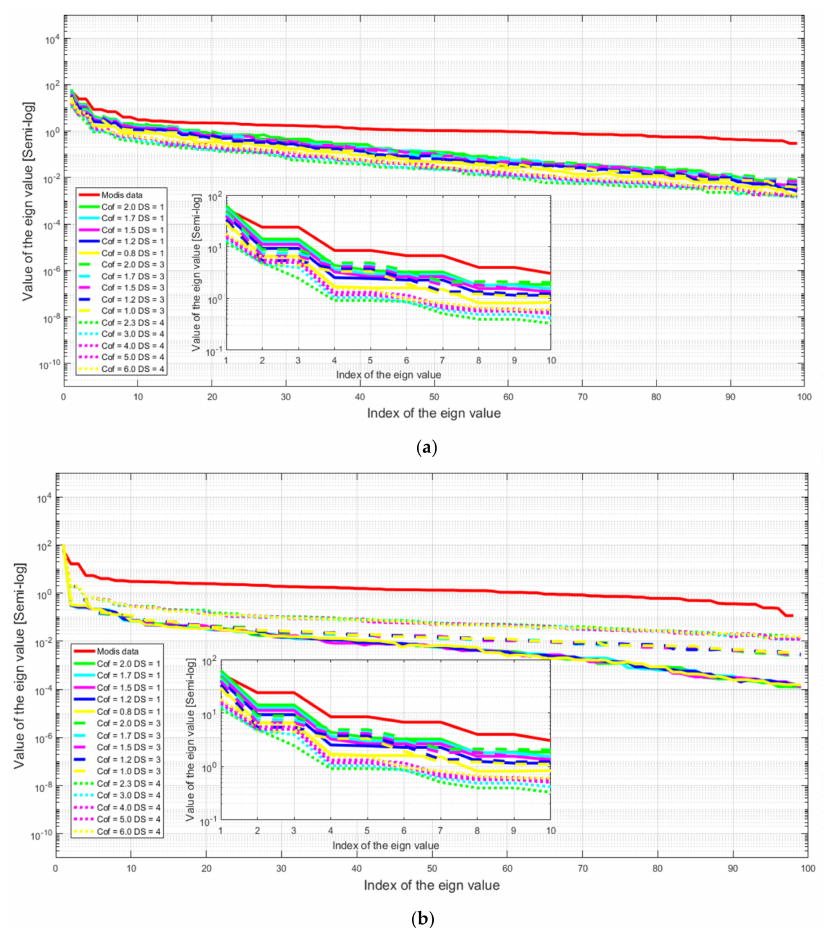
Figure 8. Eigen values for ( a ) AOD (top) and ( b ) single scattering albedo (SSA) (bottom) distributions from MODIS and Model’s results using all the dust schemes for the dust event of January